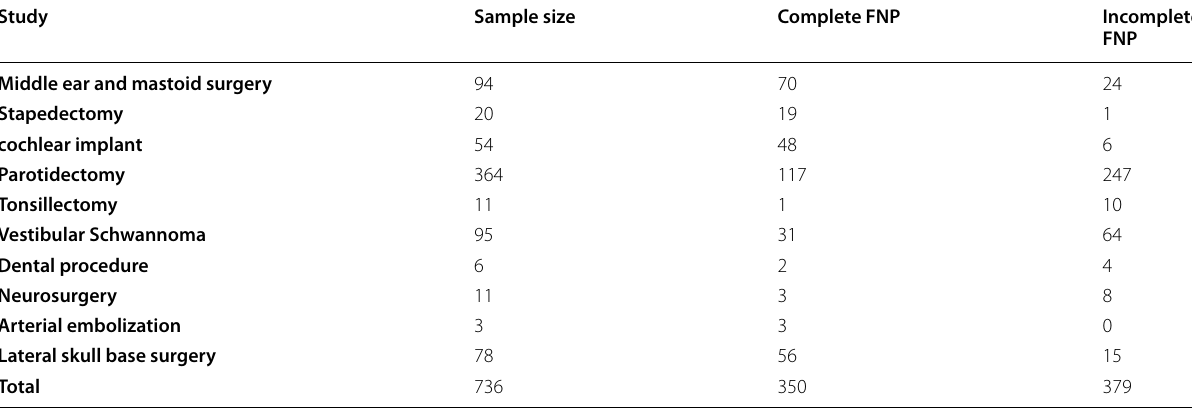
Table 4 Clinical picture of facial nerve